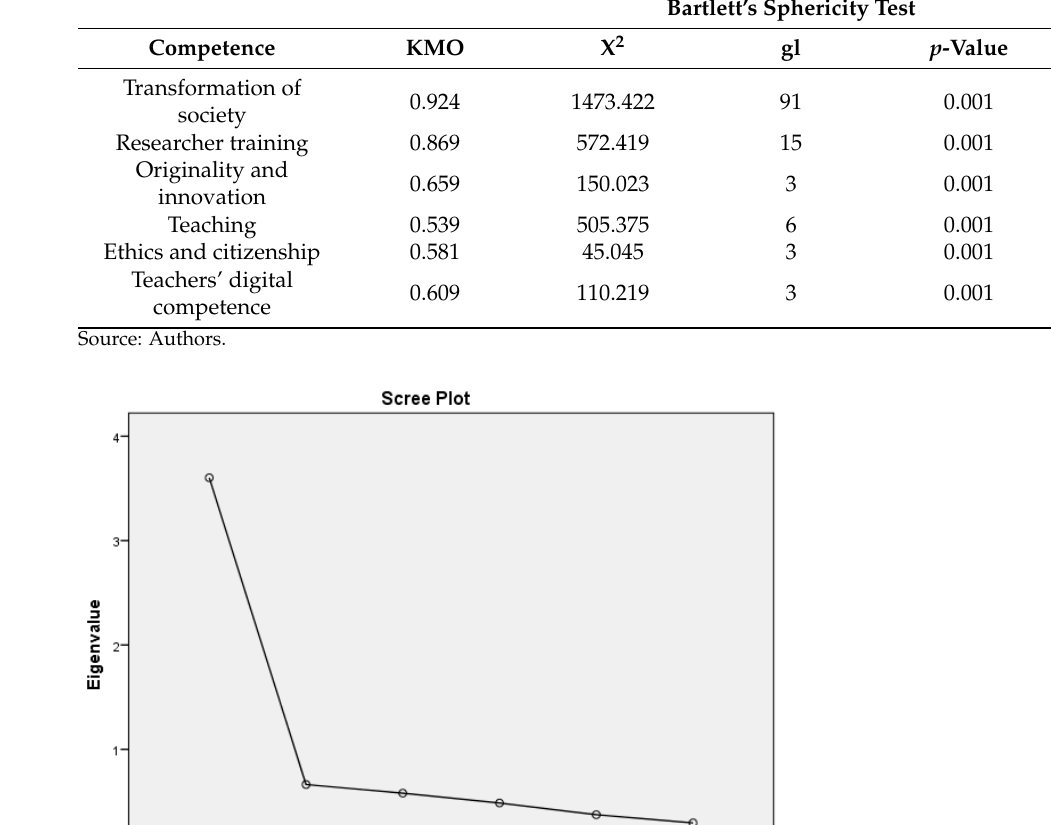
Figure 4. Sedimentation graph of the competence of Originality and Innovation. Source: Authors.